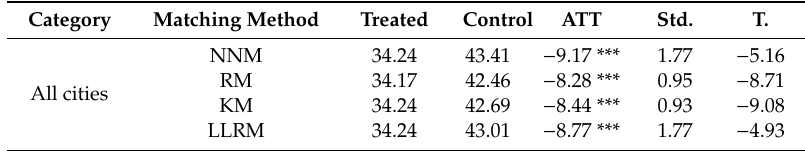
Table 3. Average treatment e ff ect on the treated (ATT) estimates under full-sample